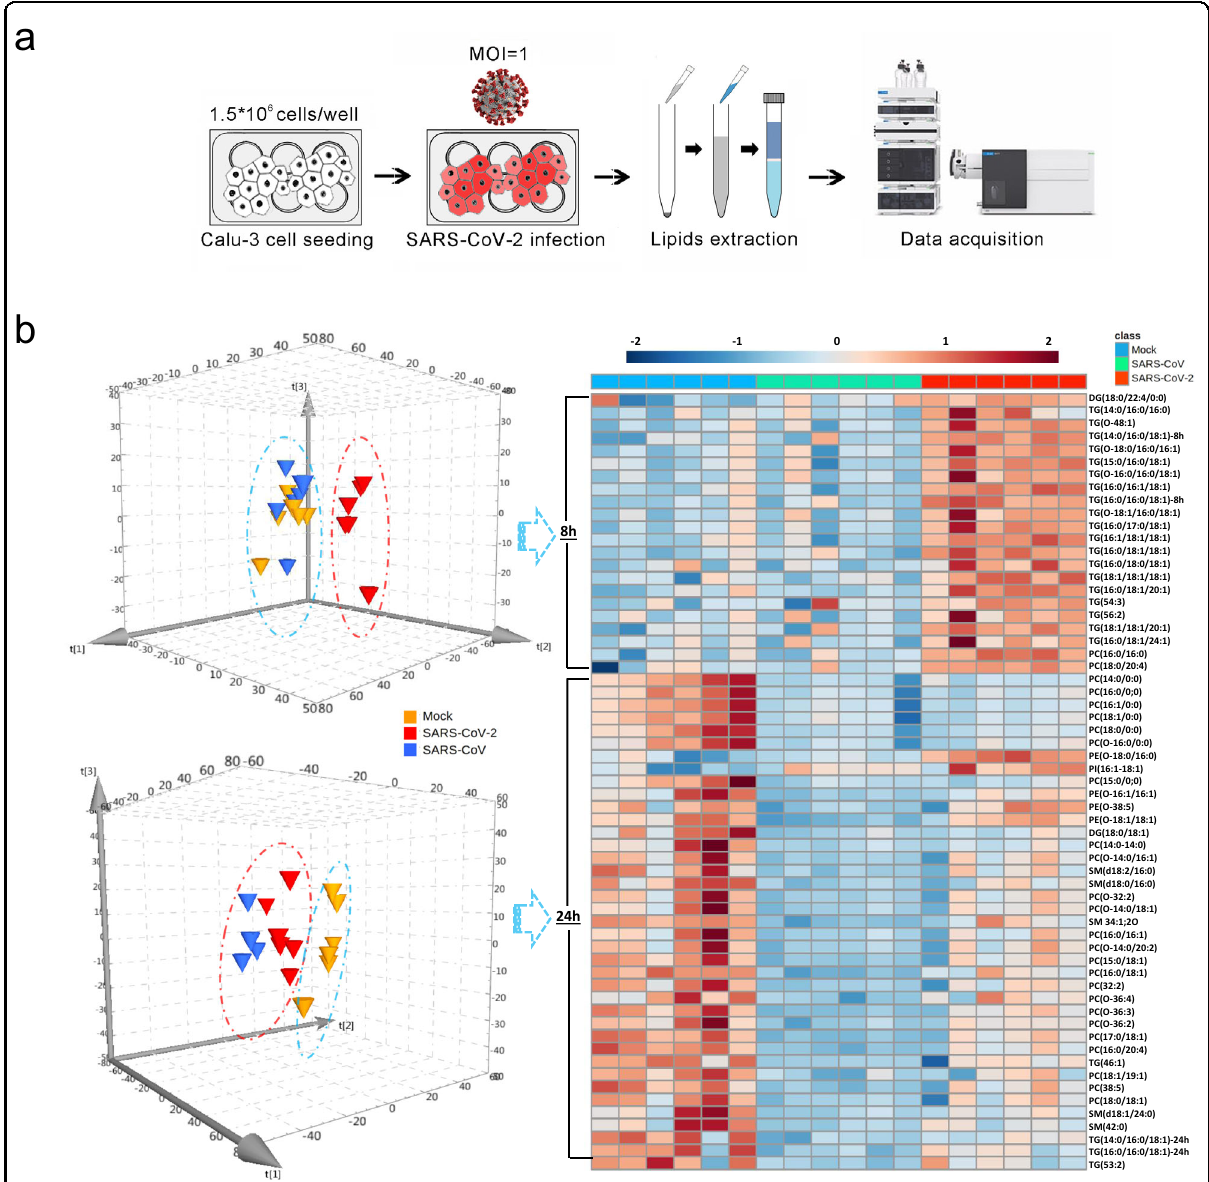
Fig. 2 Comparative lipidome between SARS-CoV- and SARS-CoV-2- infections. a Schematic fl ow chart showing the comparative analysis between SARS-CoV- and SARS-CoV-2- infections. Human lung Calu-3 cells were infected (1 MOI) by SARS-CoV or SARS-CoV-2, followed by lipid extraction at 8 and 24 hpi, respectively. b Hierarchical clustering analysis was generated based on all signi fi cantly increased/decreased lipids comparing either SARS-CoV- or SARS-CoV-2- infection with that of mock infection, respectively. The 3D principal component analysis (PCA) score plots showing the distribution pattern of the detectable lipid pro fi le, which differentiate SARS-CoV-2-infection (red) from mock- nfection (yellow) and SARS-CoV-infection (blue) groups. The triangles represent the distribution of an individual sample dot within each group ( n =